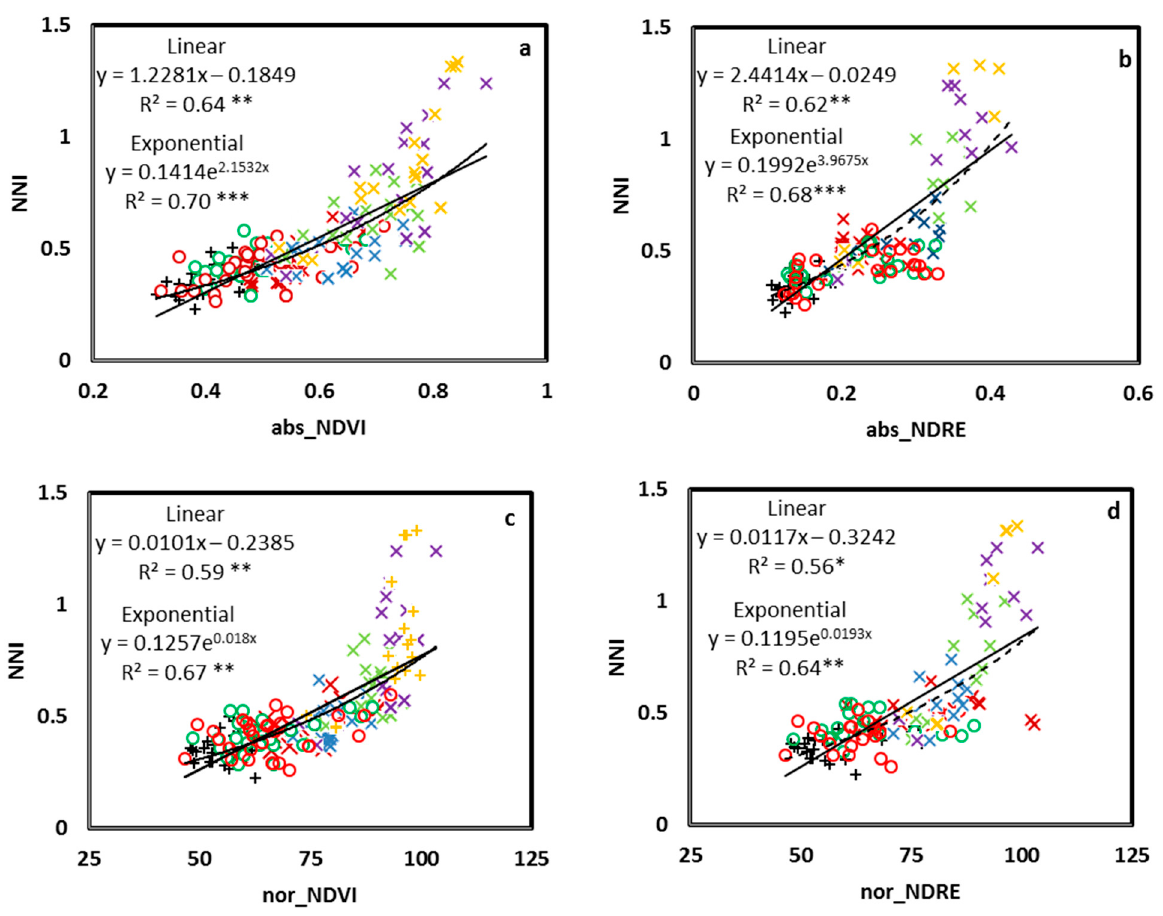
Figure 4. Relationship between the abs_NDVI ( a ) and abs_NDRE ( b ) values for all growing stages measurements together and the NNI (Nitrogen Nutritional Index) and the nor_NDVI ( c ) and nor_NDRE ( d ) values for all growing stage measurements together and the NNI. Two models were fitted: linear, solid line; exponential, dashed line. *, **, *** Significant at 0.05, 0.01 and 0.001 probability levels, respectively. + , 0N; × , 40N + 0N; × , 40N + 40N; × , 40N + 80N; × , 40N + 120N; × , 40N + 160N; o , DS + 0N; o , SM + 0N. abs, absolute values; nor, normalized values; NDVI, Normalized Difference Vegetation Index; NDRE, Normalized Difference Red Edge Index.